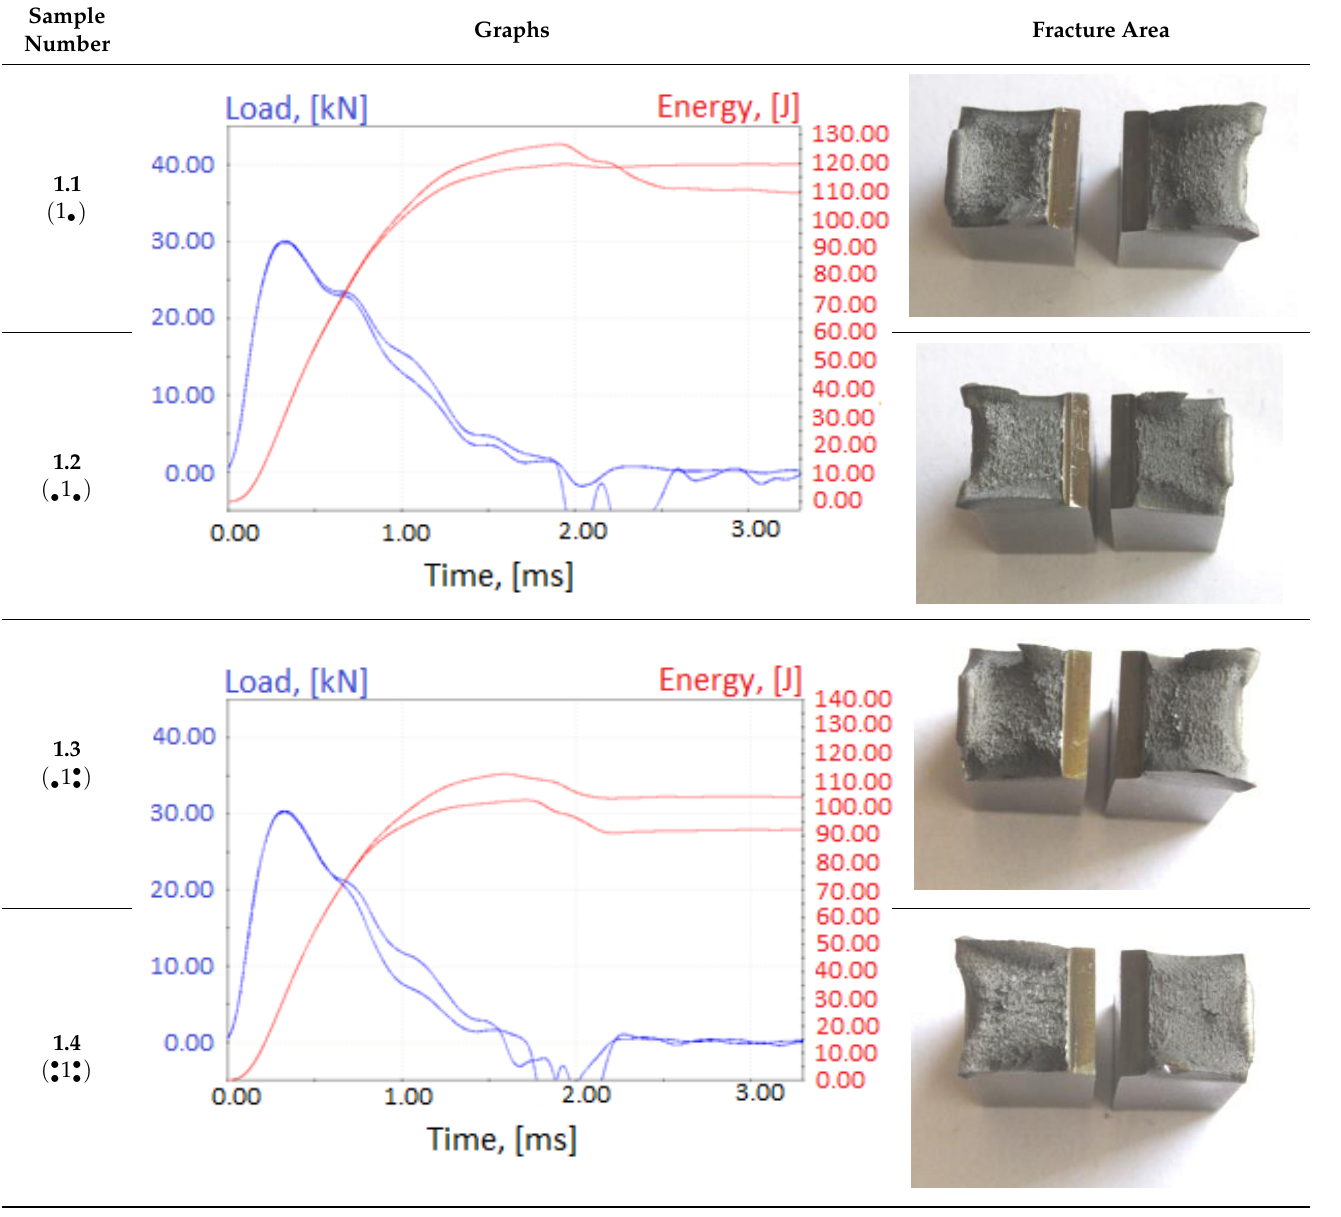
Table 7. Test results: fracture pictures and graphs of exerted energy and load (material after heat treatment). Sample